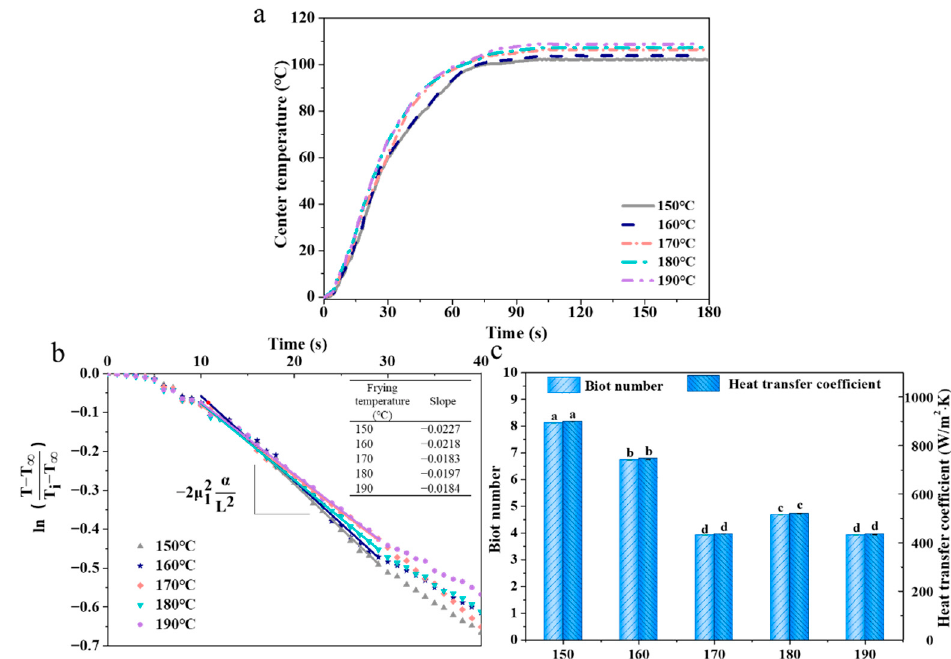
Figure 1. Effect of frying temperature on the center temperature ( a ), slope of linear sections of dimensionless temperature ratio vs. time plots ( b ), Biot number and heat transfer coefficient ( c ) in French fries. The results are the mean ± SE. Different letters (a–d) indicate significant differences ( p ≤ 0.05).